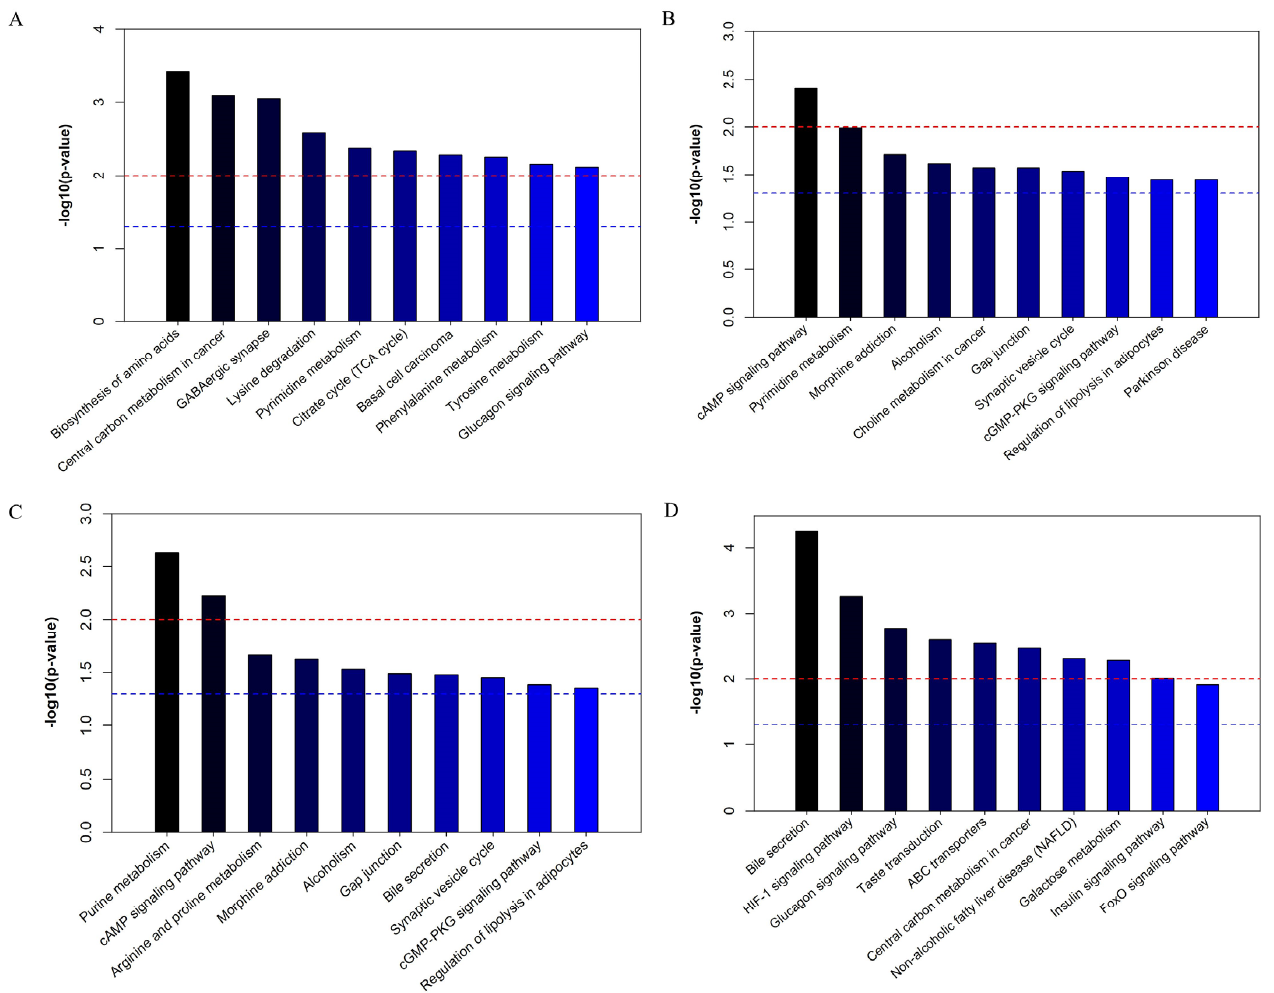
Figure 4. A pathway enrichment analysis of differential metabolites after treatment of LYCRPLs: ( A ) metabolic pathway enrichment map between group K and group M; ( B ) metabolic pathway enrichment map between group GA and group M; ( C ) metabolic pathway enrichment map between group GB and group M; ( D ) metabolic pathway enrichment map between group GC and group M. Note: ( A – D ) p < 0.05 means significant, and the smaller the p value, the more significant the difference in the metabolic pathway. The red line indicates that the p value is 0.01 and the blue line indicates that the p value is 0.05.